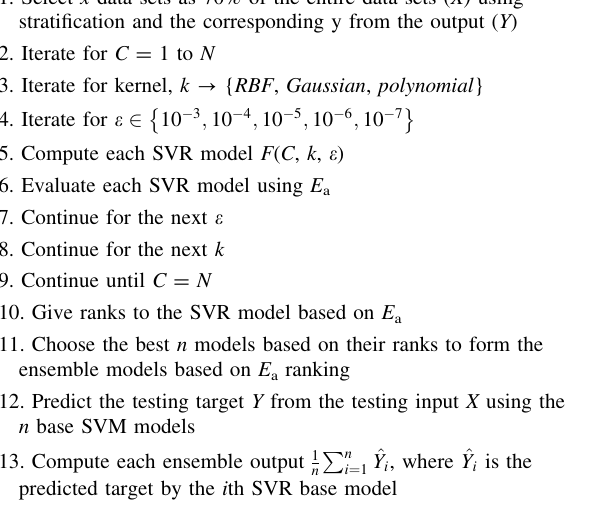
Algorithm 1: Ensemble support vector machine